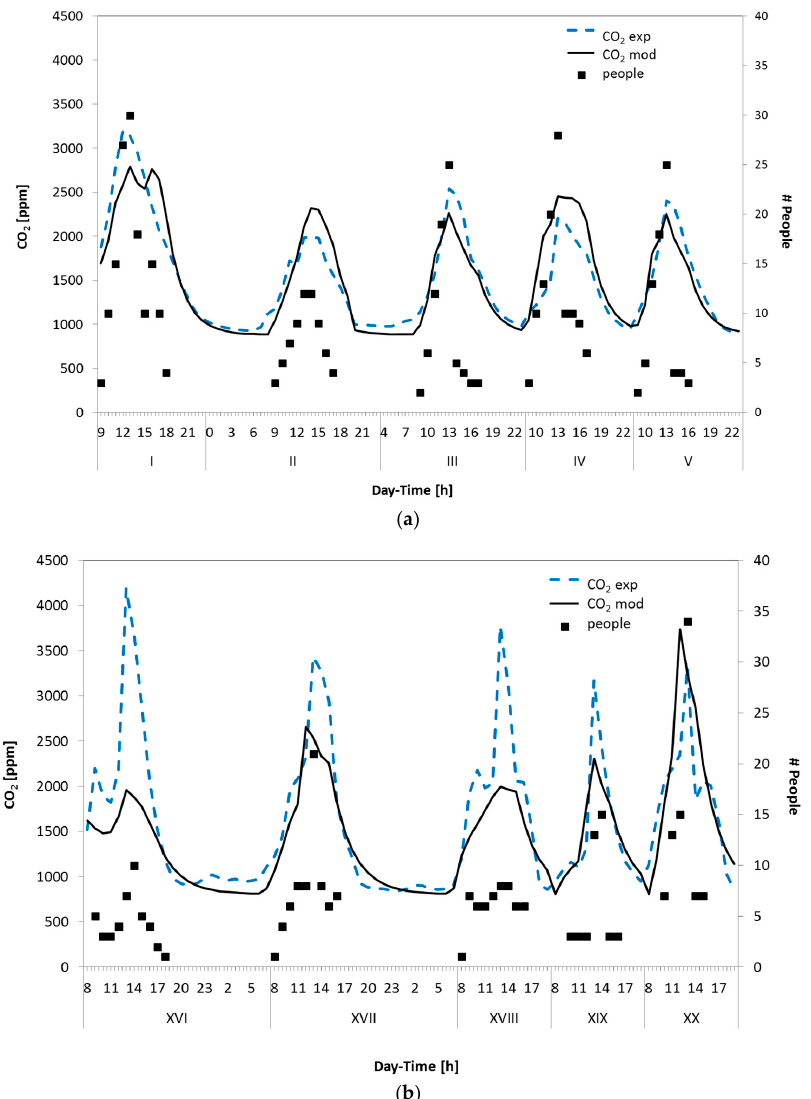
Figure 4. Experimental and predicted CO 2 concentration trends and number of occupants inside